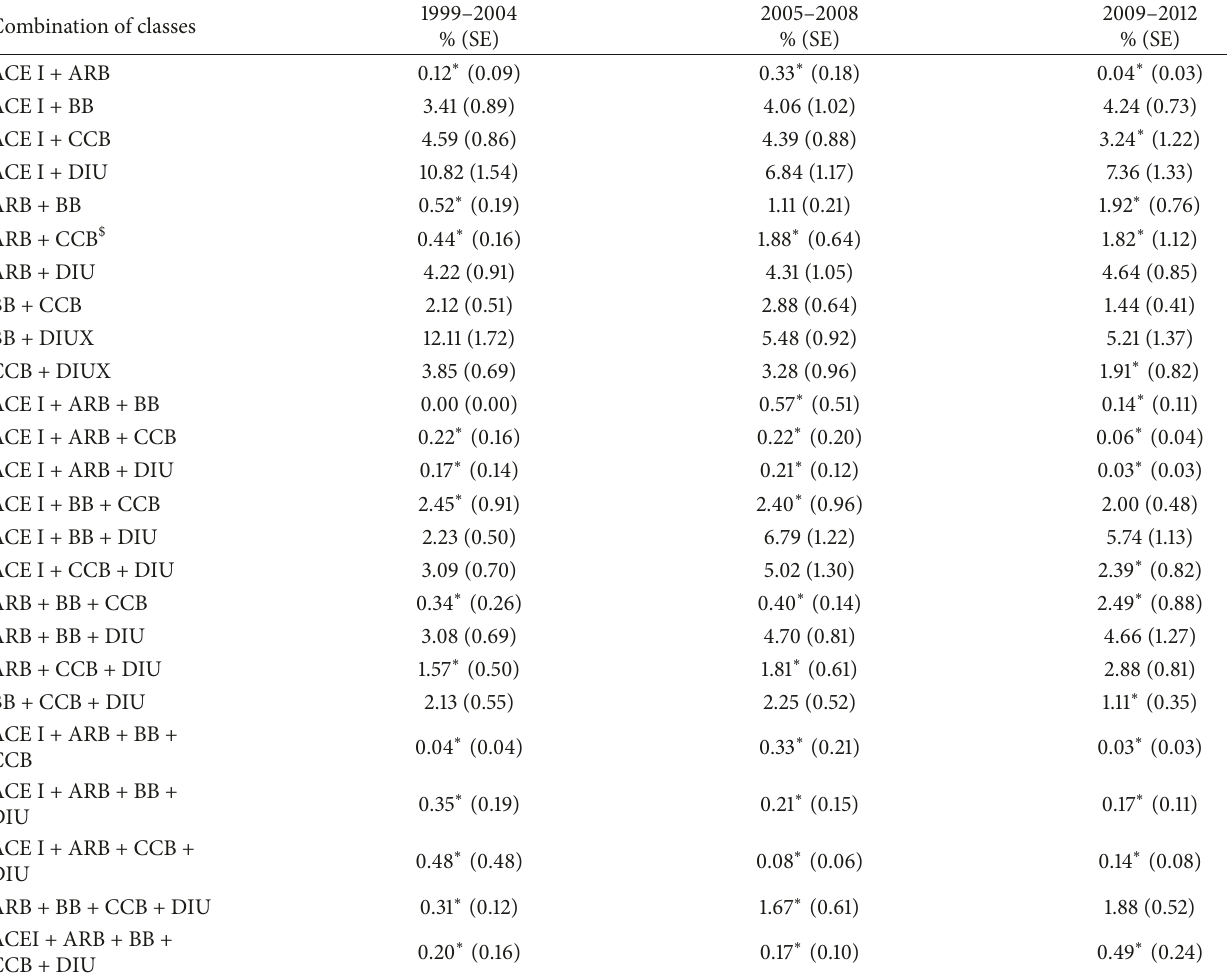
Table 3: Age-standardized prevalence of American adults (18 years of age or older) with hypertensive CKD treated For hypertension by combination of five classes of medications: NHANES